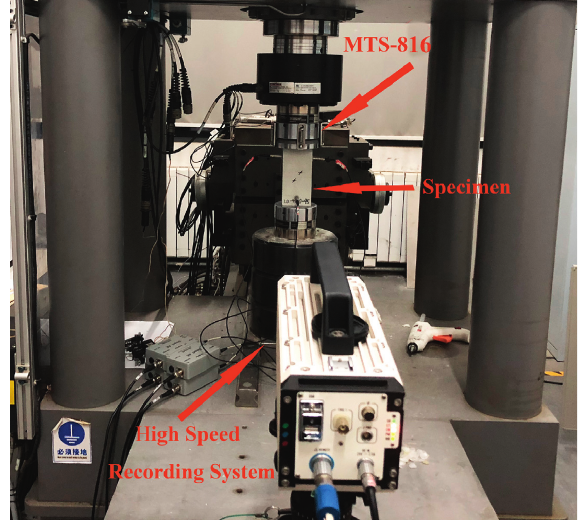
Figure 4: The rock mechanics testing system used for the uniaxial compression tests of the sandy mudstone specimens with the prefabricated